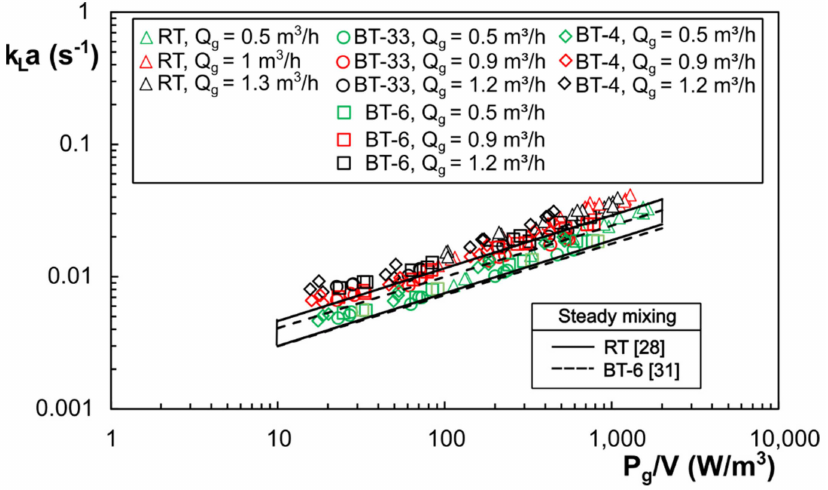
Figure 7. Relation between volumetric mass transfer coefficient k L a and P g /V for BT-33, BT-4, BT-6, and RT impellers.